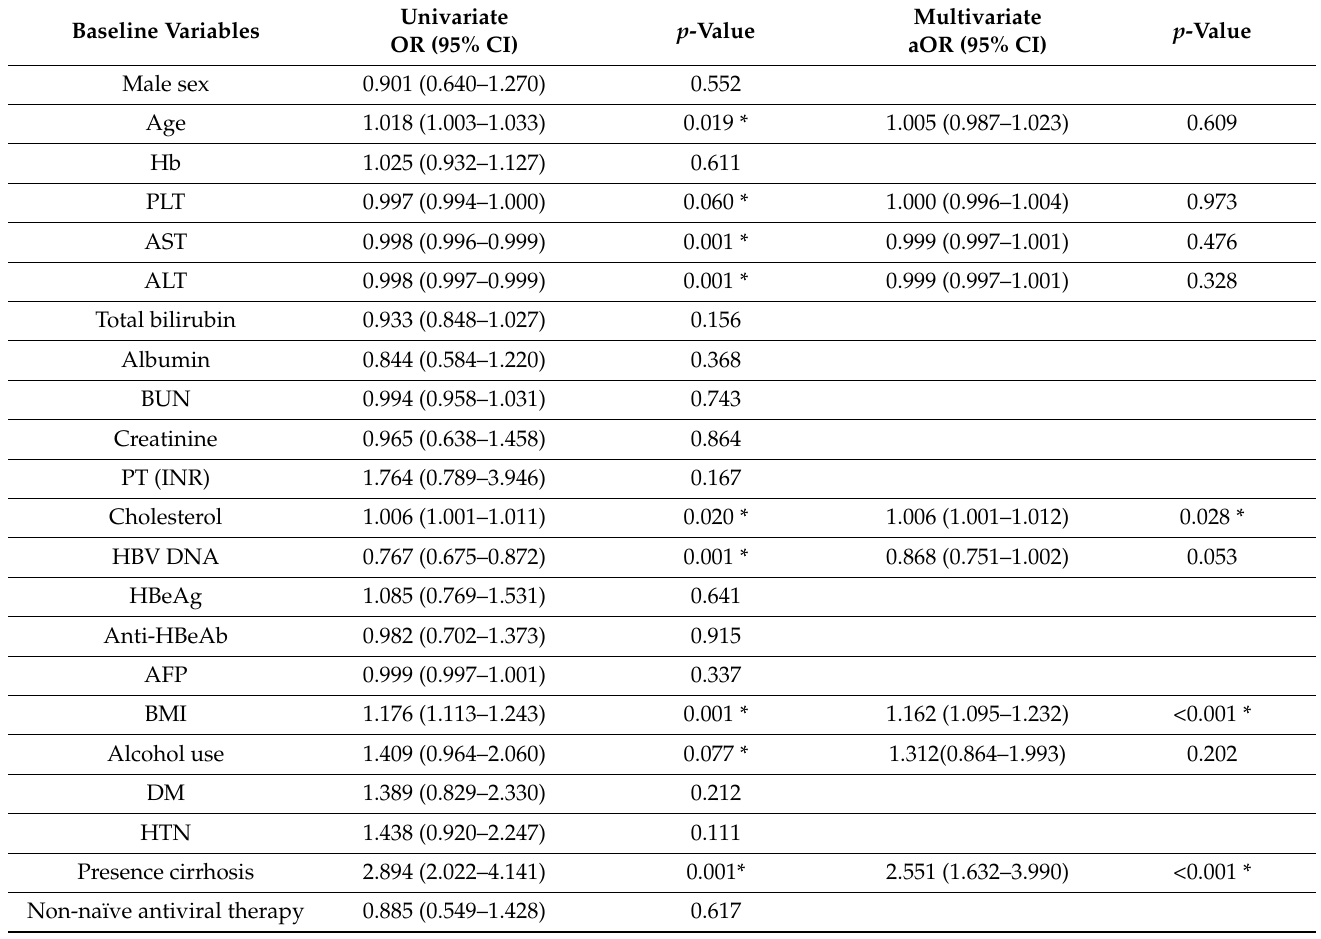
Table 4. Univariate and multivariate analyses for ALT